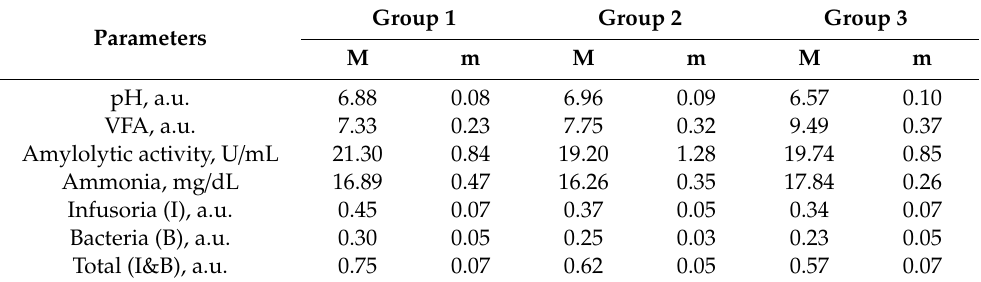
Table 4. The major parameters (M ± m) of a rumen fluid of rumen-fistulated ewes.